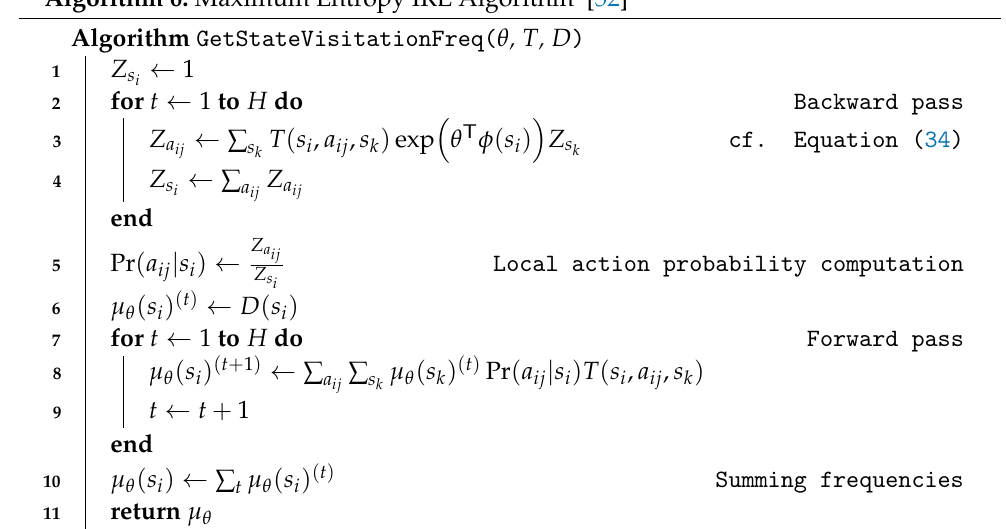
Algorithm 6: Maximum Entropy IRL Algorithm